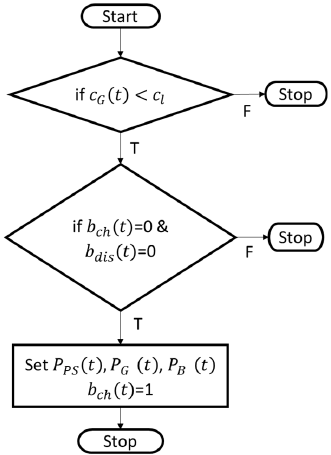
Figure 4. Simplified Logic Flow Diagram for Battery Charging.